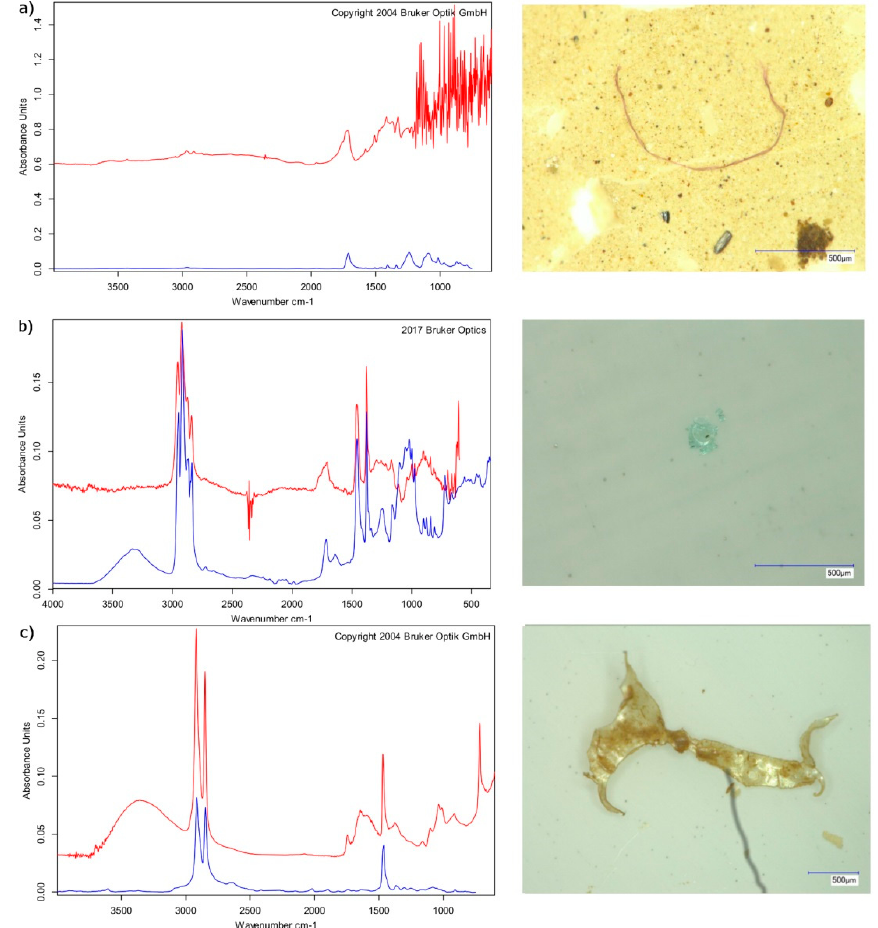
Figure 6. µFTIR spectra (red: measured spectrum, blue: reference spectrum from the Bruker spectral database) of analysed microplastics: ( a ) red polyester fibre, ( b ) green polypropylene fragment, ( c ) transparent polyethylene foil.